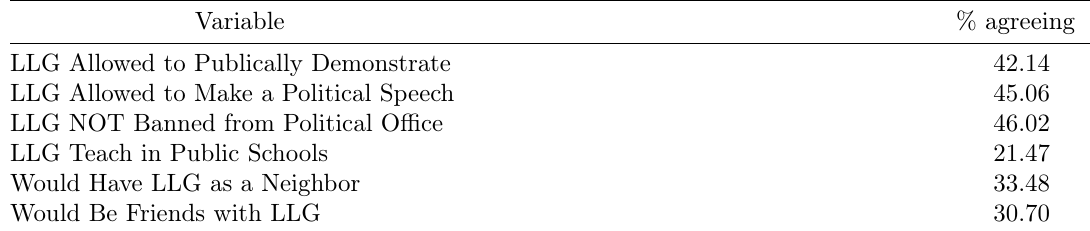
Table 2: Descriptive Statistics for Least Liked Groups